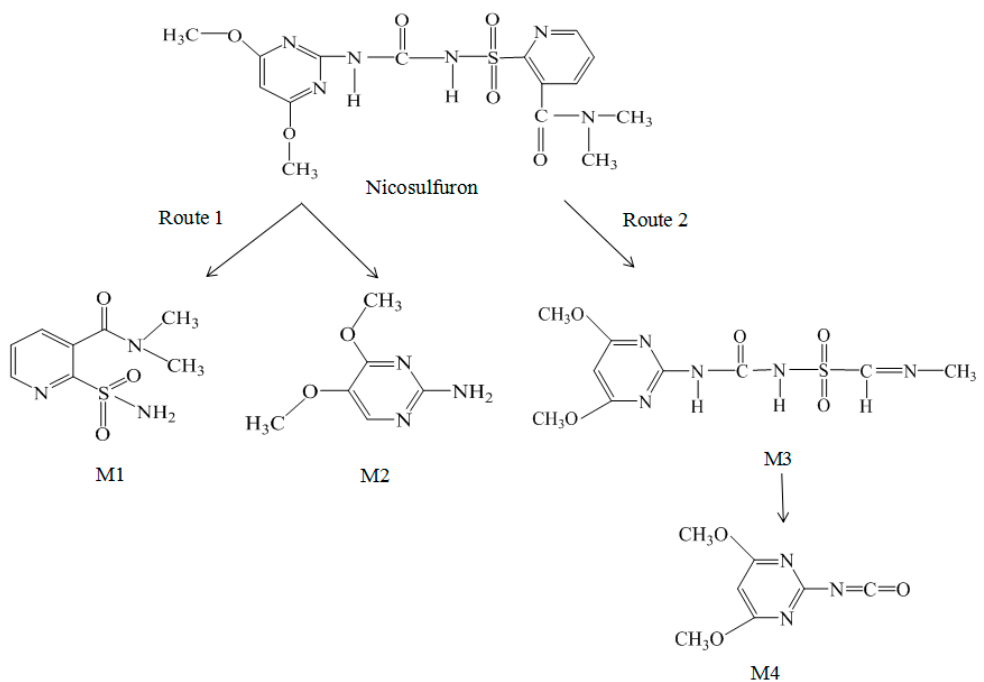
Figure 15. Degradation mode under the conditions of nicosulfuron electrolysis.